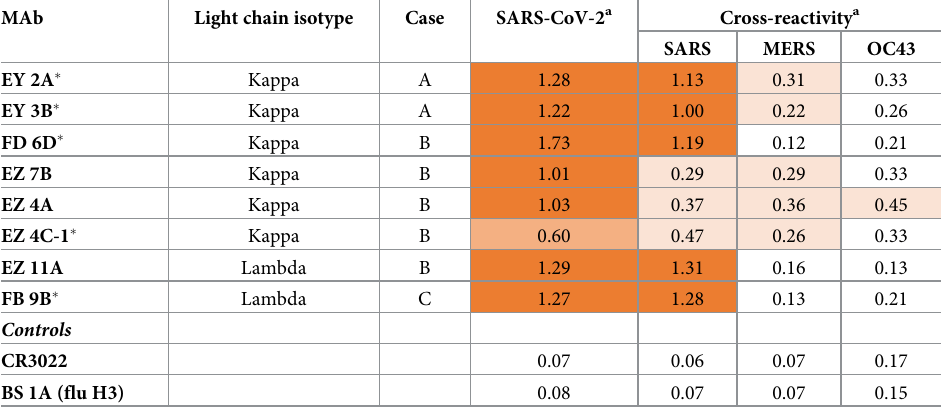
Table 3. The antigenic specificity and cross-reactivity of 8 anti-SARS-CoV-2 nucleocapsid monoclonal antibodies derived from COVID-19 patients. MAb Light chain isotype